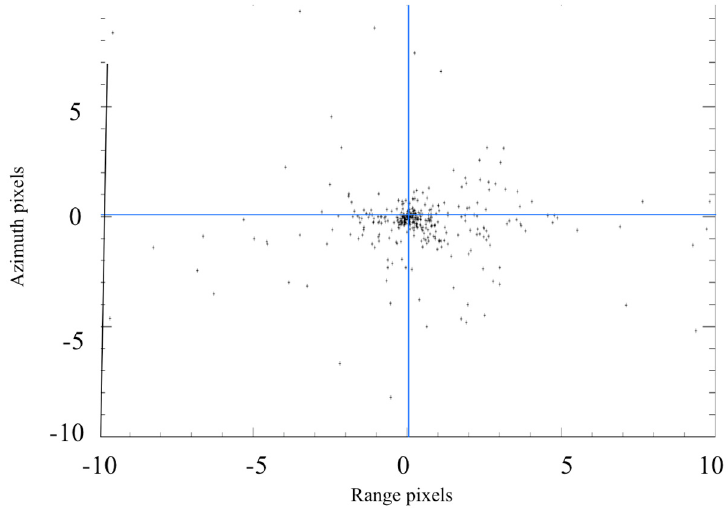
Figure 1. Mean offsets of 388 UTM grid-zone-projected path images from SRTM